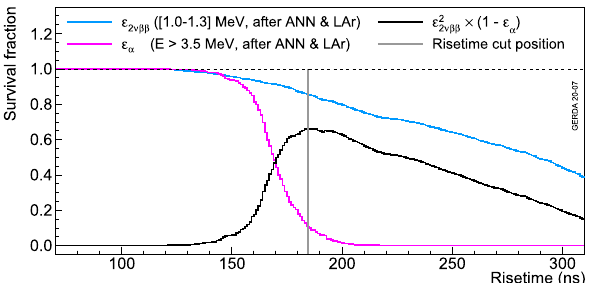
Fig. 13 Survival fractions after the rise time cut for 2 νββ decay and α particles events from the Phase II data before the upgrade of the ANG4 detector. Also shown are the figure of merit and the chosen cut value